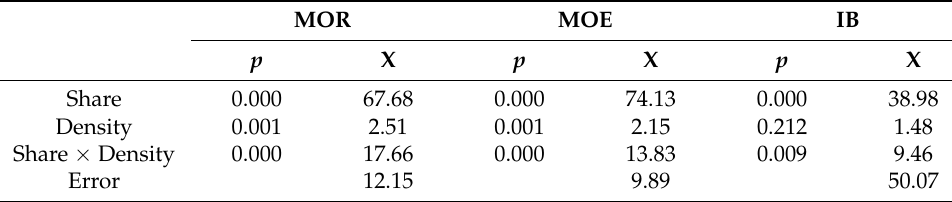
Table 3. MANOVA results of mechanical properties of